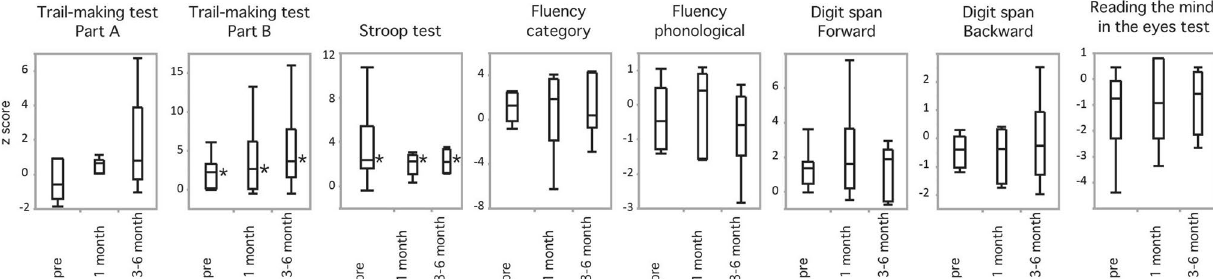
Figure 4. Box-plot representing median Z scores on eight functional batteries performed for 7 patients in the SupTR group preoperatively, 1 month after resection, and 3 to 6 months after resection. Asterisks indicate